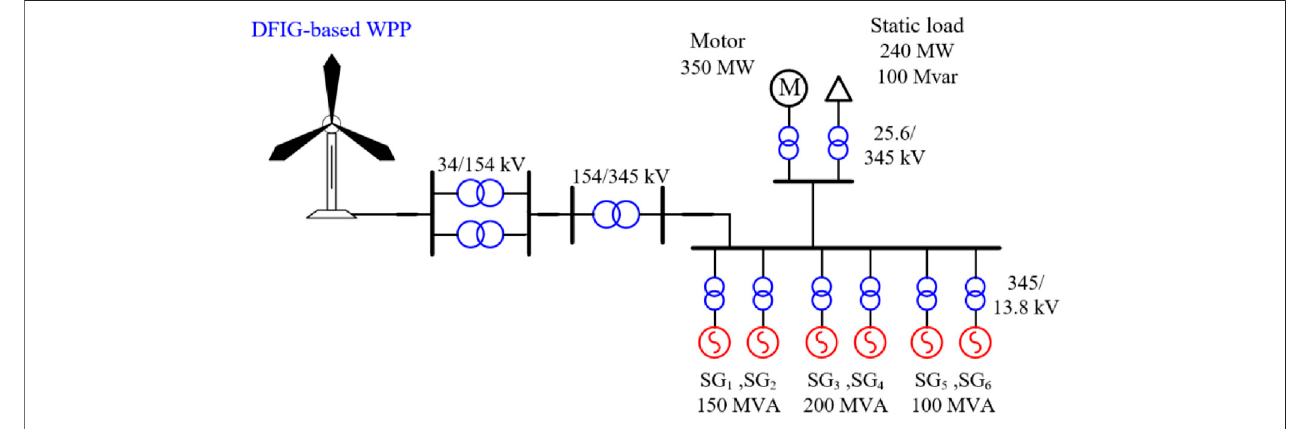
FIGURE 5 | Model system with an aggregated wind farm.